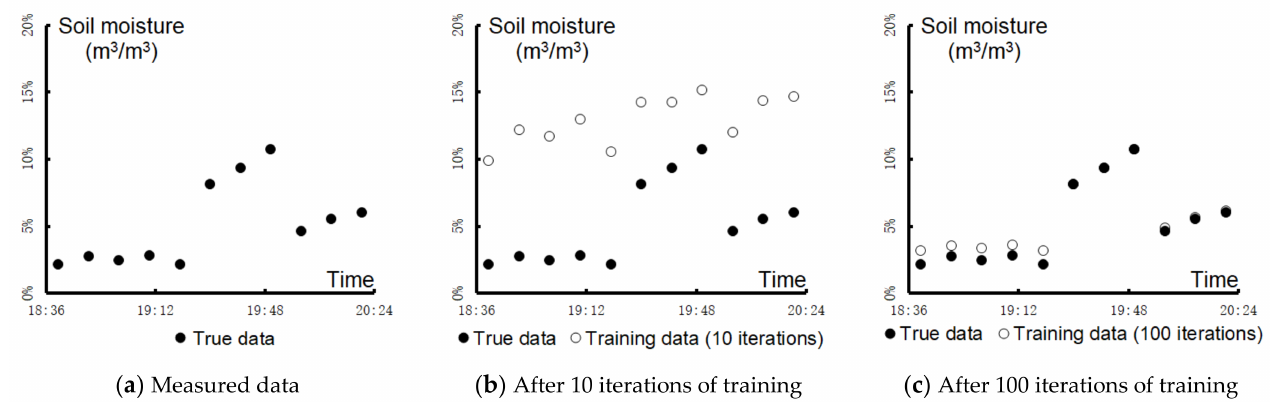
Figure 14. Analysis of data exceptions using the BP neural network